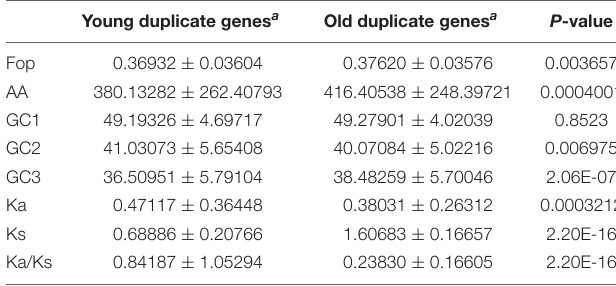
TABLE 2 | Comparison of gene complexity and substitution rate between young and old duplicate genes in Vernicia fordii . Young duplicate genes